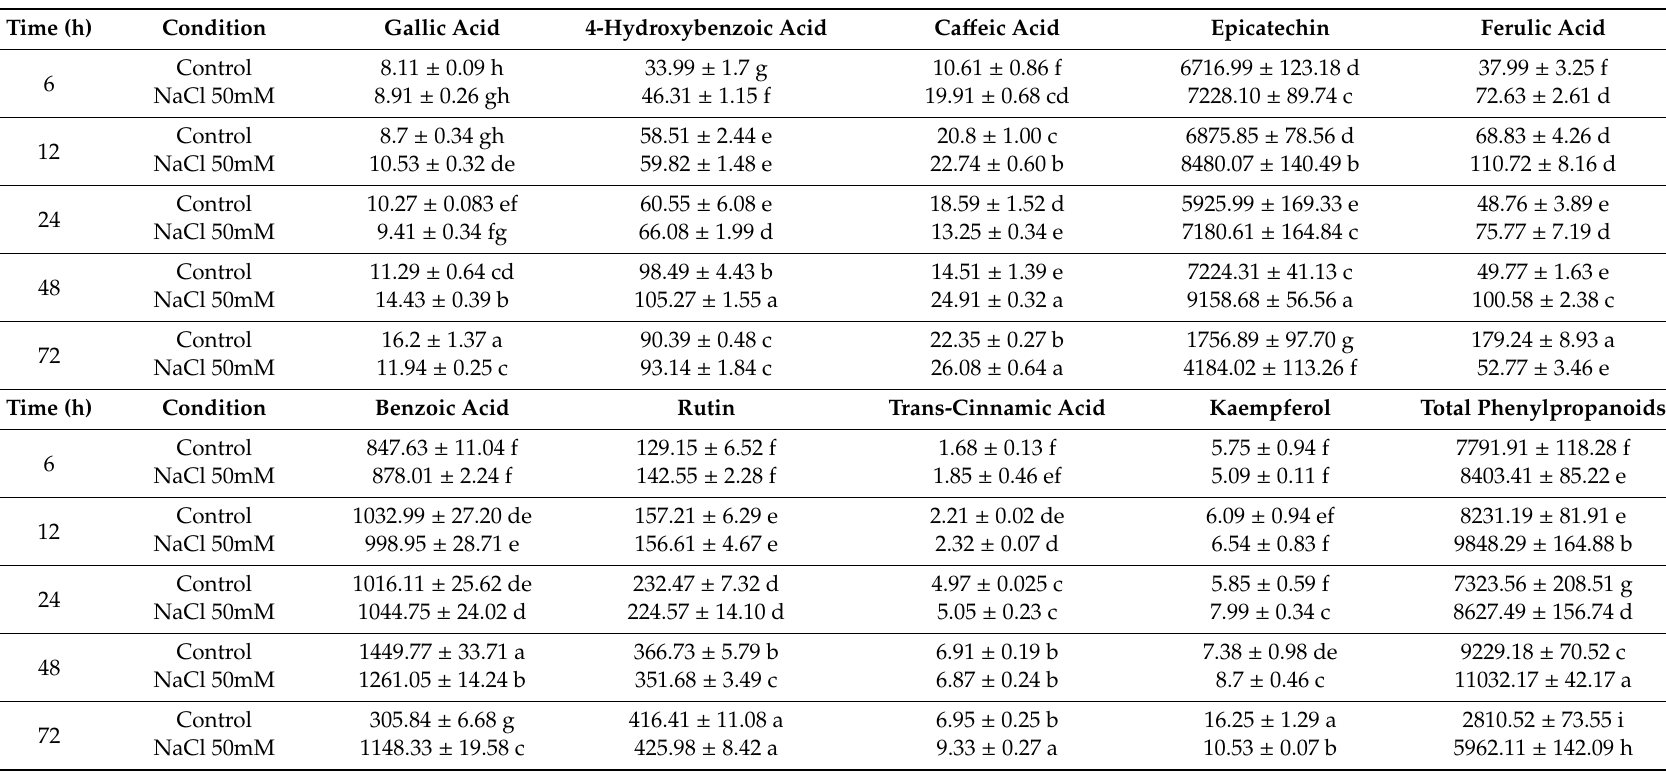
Table 3. The Phenylpropanoid level ( µ g g − 1 dry weight) in 6 days old wheat plantlets at 6, 12, 24, 48, and 72 under the condition of 50mM NaCl. The means and SD were calculated from three biological replicates. Letters a-h denotes significant di ff erences ( P <